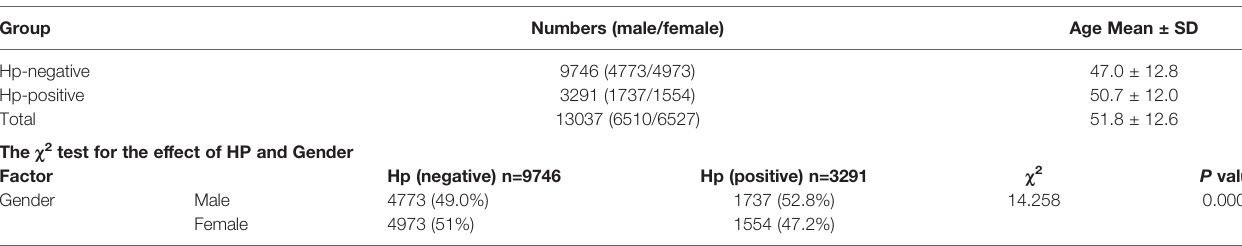
TABLE 1 | Analysis of Hp